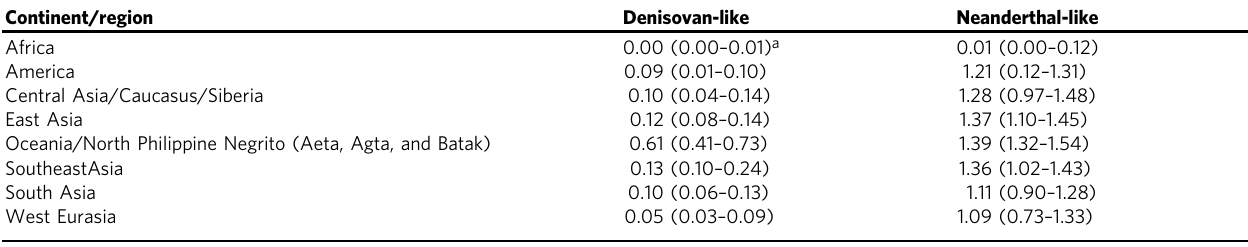
Table 1 Estimated introgression proportions (%) on different continents/regions.